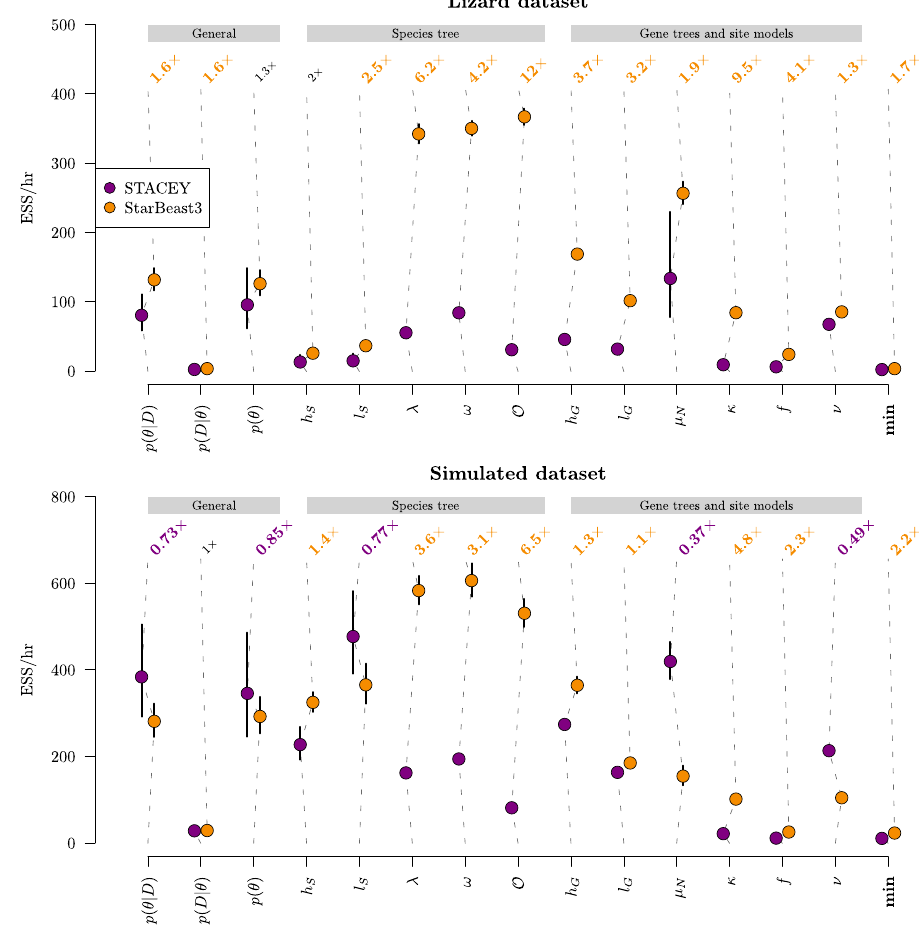
Fig. 3 Comparison of parameter exploration ef fi ciencies between STACEY and StarBeast3, under the birth-collapse tree prior. The average effective samples generated per hour ( ± 1.96 se) are plotted for each term. Top of each plot: the mean relative difference compares StarBeast3 with STACEY. These terms are coloured orange if StarBeast3 outperformed (and purple if STACEY outperformed) at a signi fi cant level across 20 MCMC replicates ( p < 0.05 from a two-sided t test). All means and standard errors were computed in log-space. We evaluated ESS/hr across an array of parameters, including general inference, species tree parameters, and parameters describing gene trees and substitution models. Notation -- p ( θ ∣ D ): posterior density; p ( D ∣ θ ): likelihood; p ( θ ): prior density; h S : species tree height; l S : species tree length; λ : species tree birth rate; ω : species tree collapse weight; O : species tree origin; h G : gene tree height; l G : gene tree length; μ N : mean effective population size; κ : gene tree transition-transversion ratio; f : gene tree nucleotide frequencies; ν : gene tree substitution rate; min: minimum ESS/hr across all other terms.